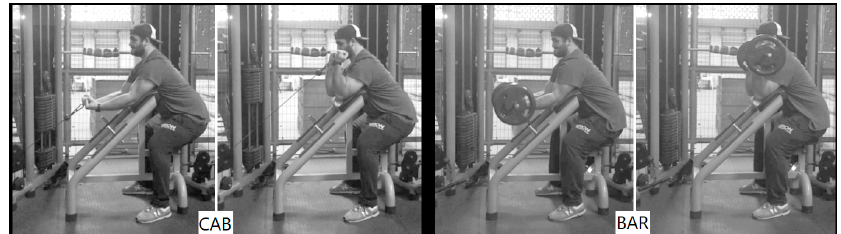
Figure 1. Examples of how cable (CAB) and barbell (BAR) preacher curls were performed.